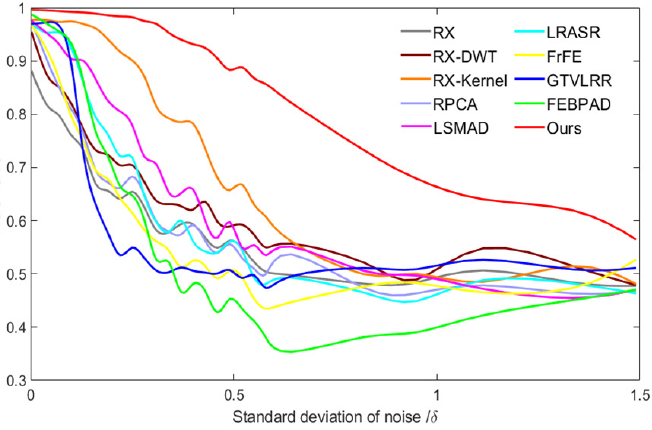
Figure 15. The AUC results on the AVIRIS-I dataset with the interference of different degrees of Gaussian